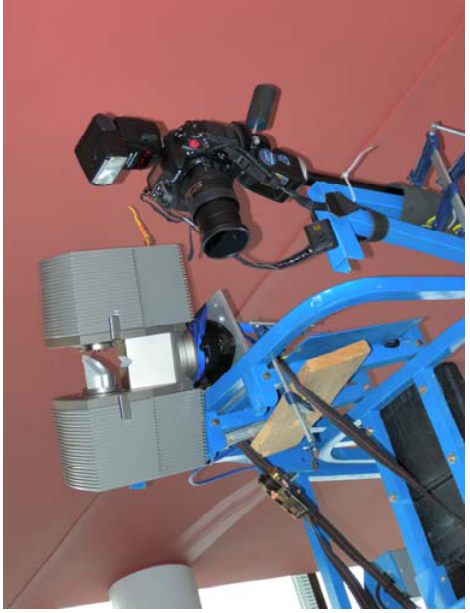
Figure 1. The FARO Photon scanner and Fuji IS PRO camera mounted on a scissor lift rack, facing downwards. The samples are placed below the